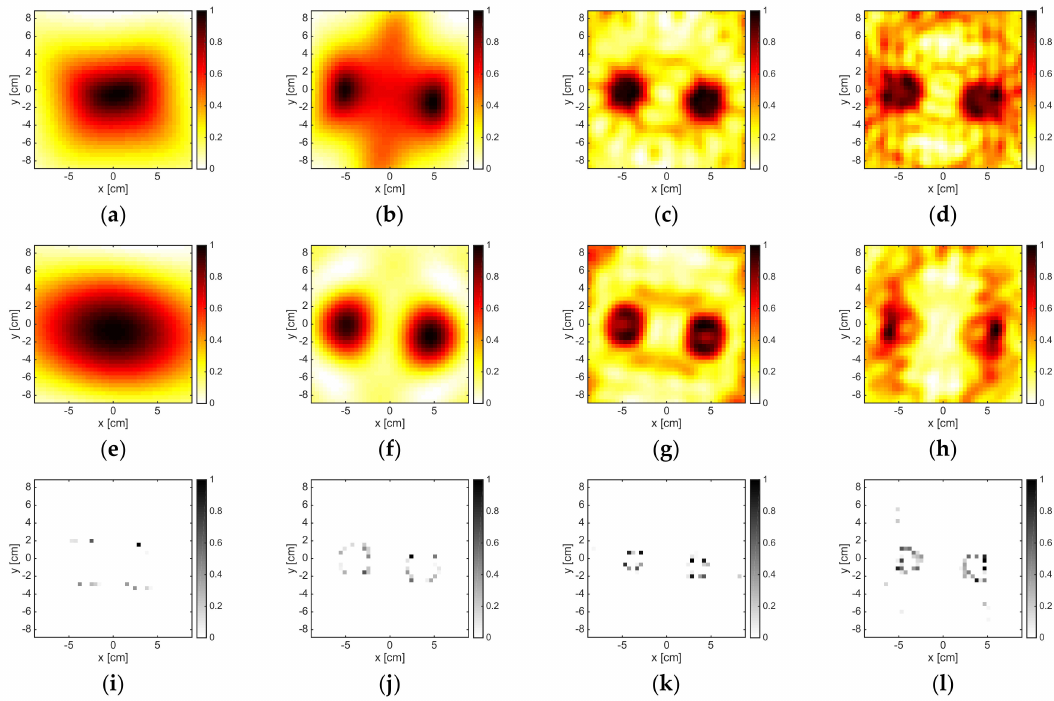
Figure 8. The TwinDielTM target. From left to right: 1 GHz, 2 GHz, 6 GHz, and 8 GHz. From top to bottom: LSM, OSM, and B-IS indicators. The number of measurements and views was M = 18.